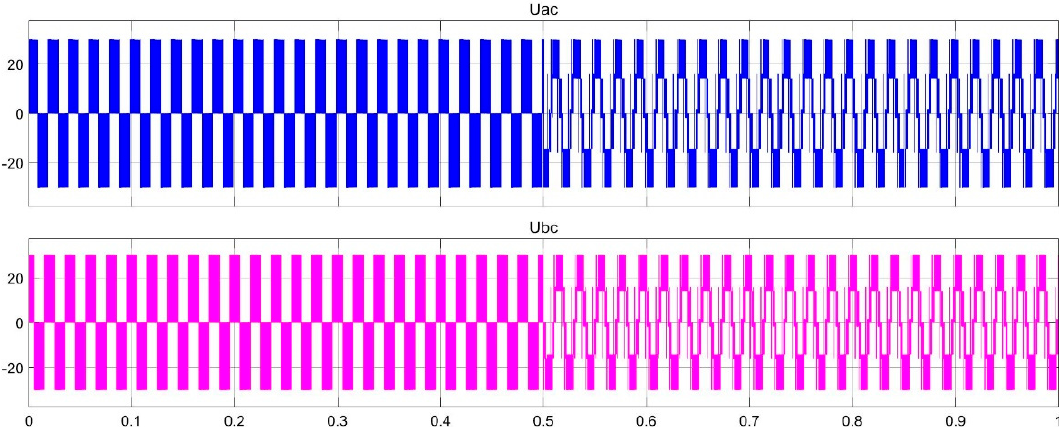
Figure 16. The simulation voltage waveform of two–three-level modulation conversion.